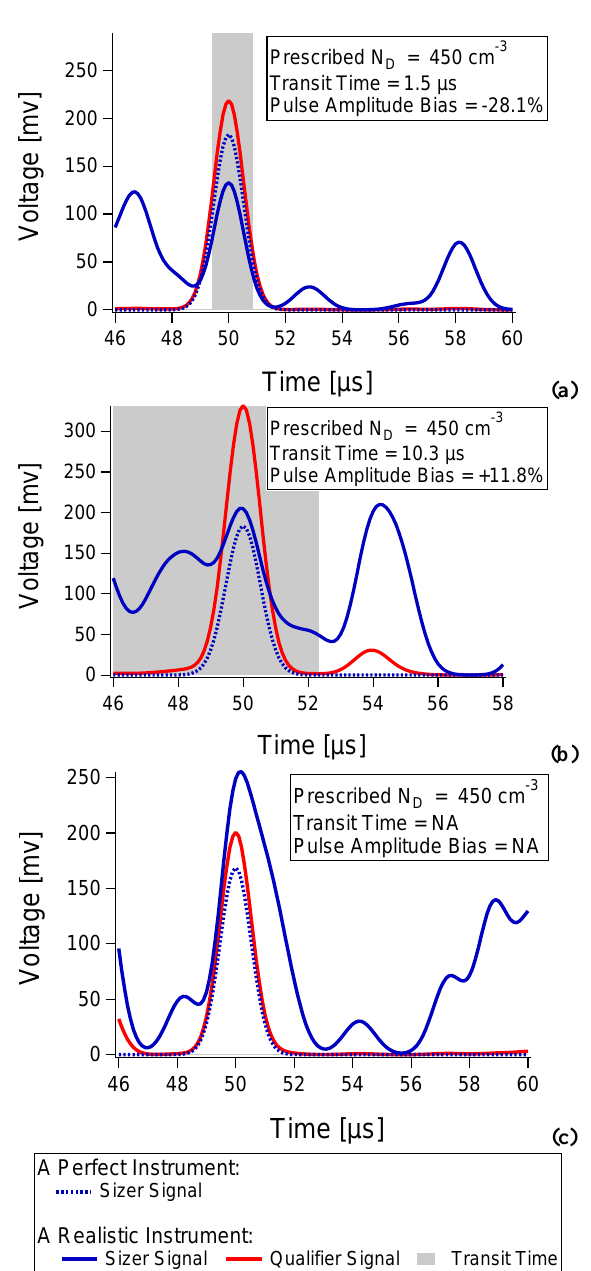
Fig. 10. Simulated electronic pulses for three different scenarios: (a) qualified droplet is undersized due to transit through a loca- tion of less sensitive instrument response within SA Q , (b) qualified droplet is oversized due to coincident droplets, (c) qualified droplet is not counted due to coincident